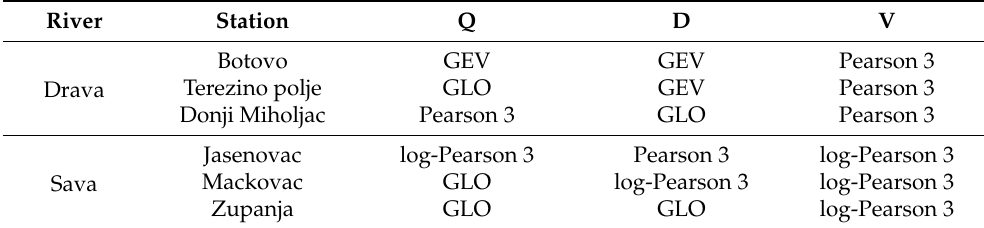
Table 7. Selected distribution functions as marginal distributions of flood peak discharge, hydrograph duration, and hydrograph